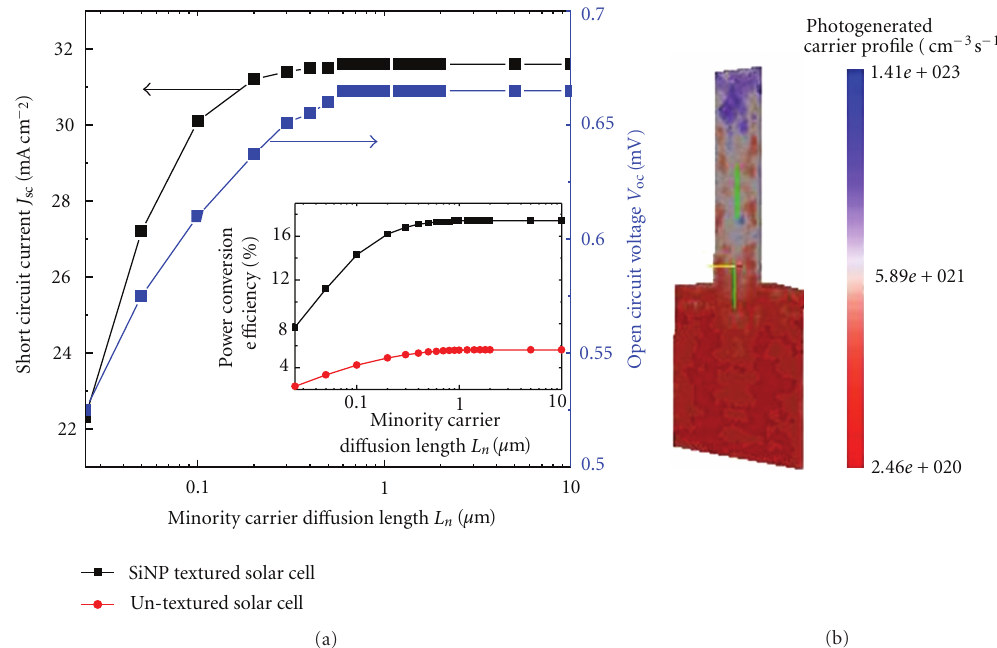
Figure 19: (a) Short circuit current and open circuit voltage of the SiNP textured solar cell at various L n . Inset is the e ffi ciency of the SiNP textured and untextured solar cell; (b) photo-generated carrier profile G in a Si nanopillar textured thin film solar cell at L n = 0 . 6 μ m. (Reprinted with permission from [59]. [2010]